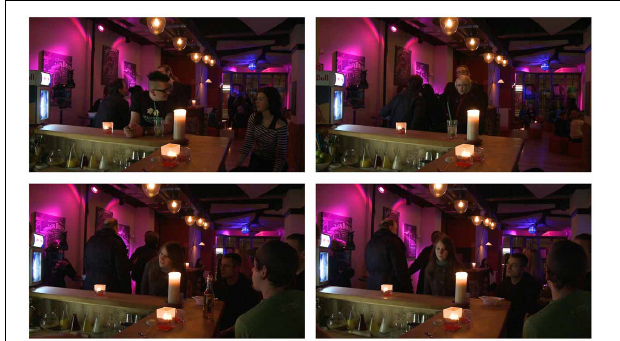
FIGURE 1 | A grid of example snapshots recorded in the “Movie,” Bielefeld. Top left : Being at bar ( no -responseexpected); Top right : Looking at bar ( no -response expected); Bottom left : Ordering ( yes -response expected); Bottom right : Not ordering ( yes -response